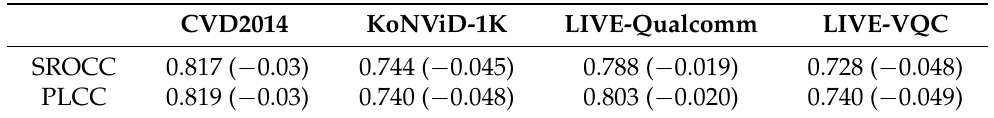
Table 7. Performance of sum fusion compared with concatenation fusion. The decline in average performance is shown in parentheses.